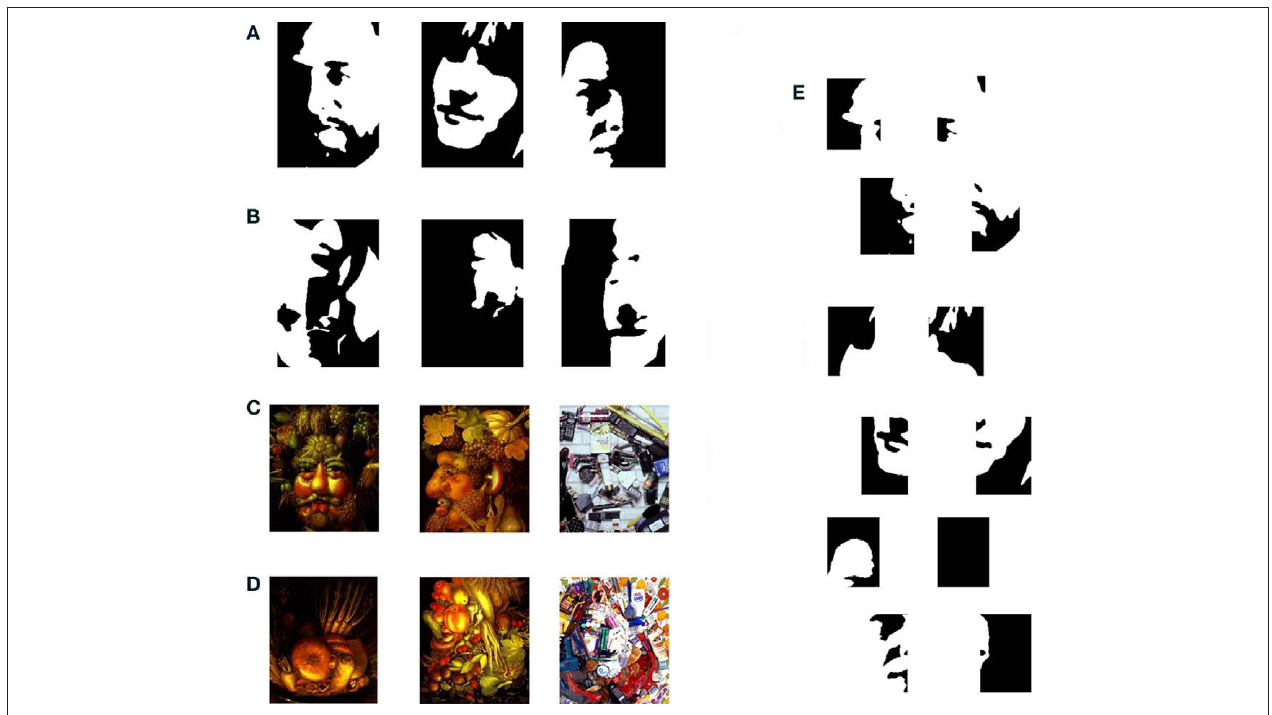
Inverted stimuli (response = non-face). (e) The three Mooney face stimuli above have been divided into four square fragments, spatially displaced. Contrary to fragments of a face photograph (e.g., Ullman, 2007), fragments of such two-tone faces cannot be seen as facelike: the stimulus needs to be perceived as a whole to see the